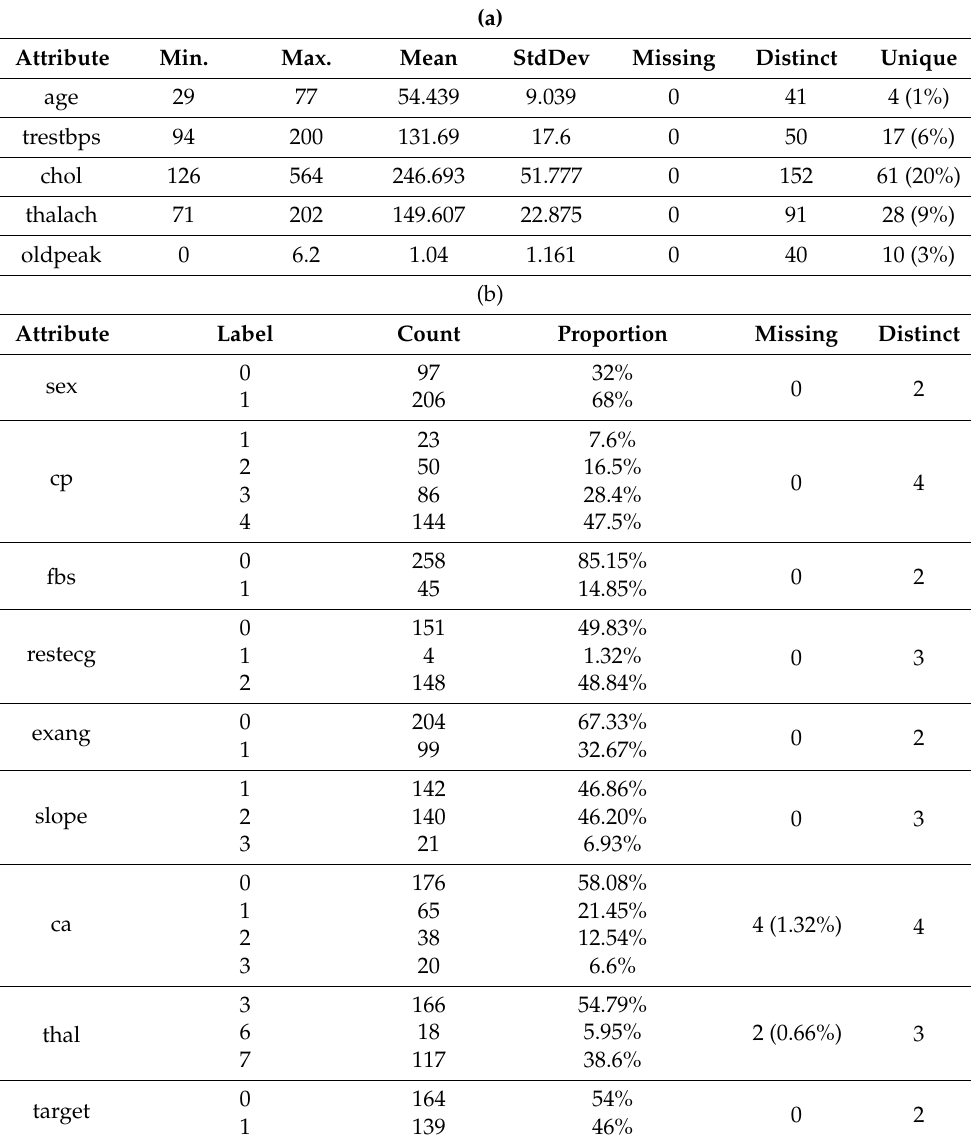
Table 2. (a) The statistical outline of the numeric attributes. (b) The statistical outline of the nominal